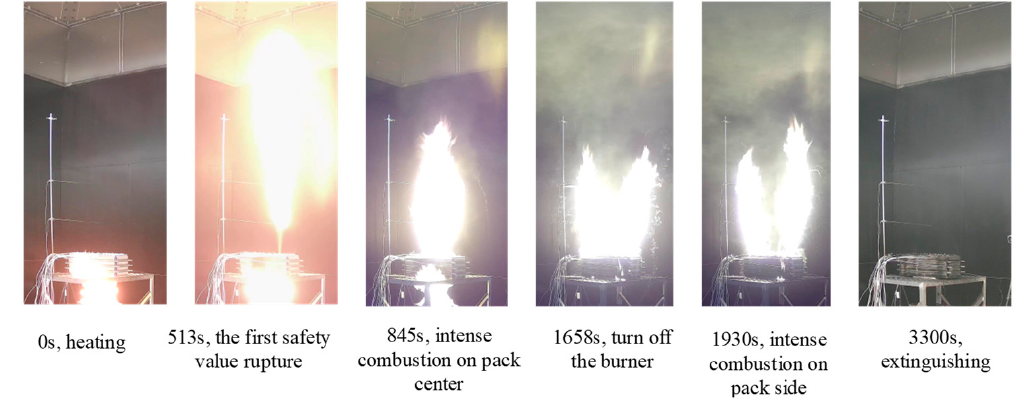
Figure 3. Combustion behavior during the TR process of the LIB pack.